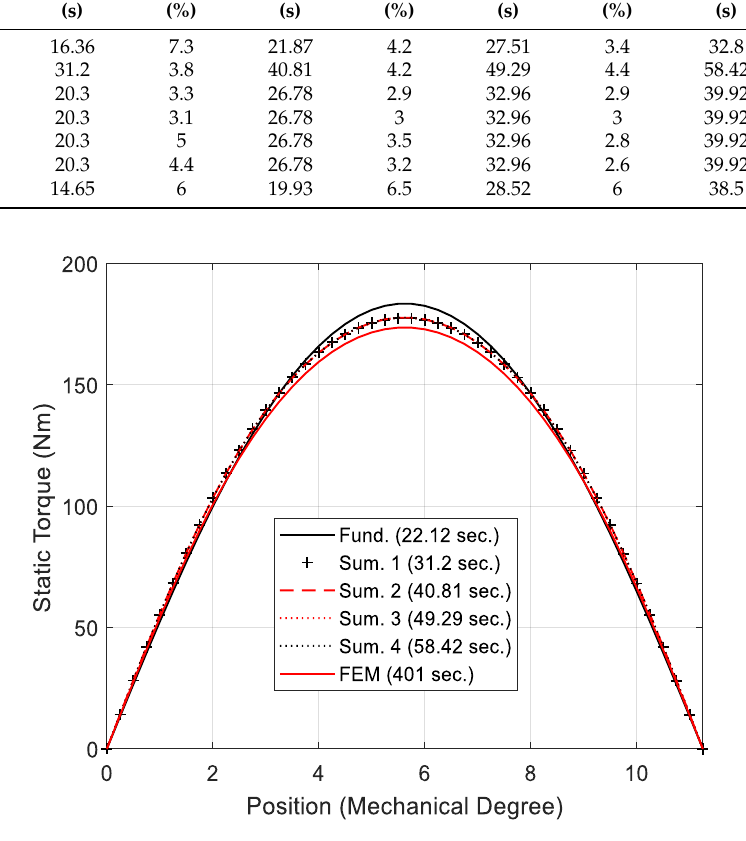
Figure 12. Case two: Static torque comparison.